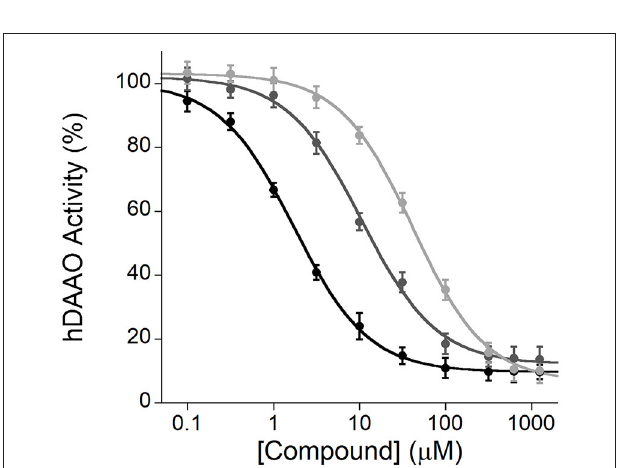
wild-type and variants RgDAAO identified following five rounds of random mutagenesis and determined on D-alanine (black), D-aspartate (gray), and D-arginine (light gray) as substrates (30mM final concentration). Figure obtained on the basis of the results published in Sacchi et al. (2004).